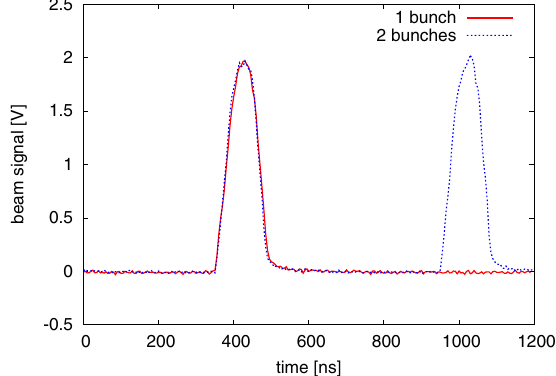
FIG. 6. Beam loss monitor signals near the dispersion peak in the arc section from injection to extraction with and without feedforward for the odd harmonics. The bunch intensity is 2 . 3 × 10 13 ppb. Also, the calculated synchrotron frequency with- out the second harmonic is plotted.